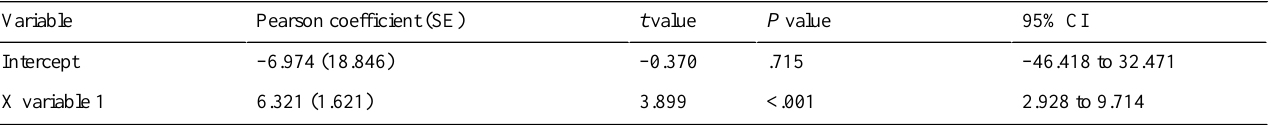
Table 1. Descriptive statistics of the linear regression of Log2(cases of COVID-19) and the RSV for the search term